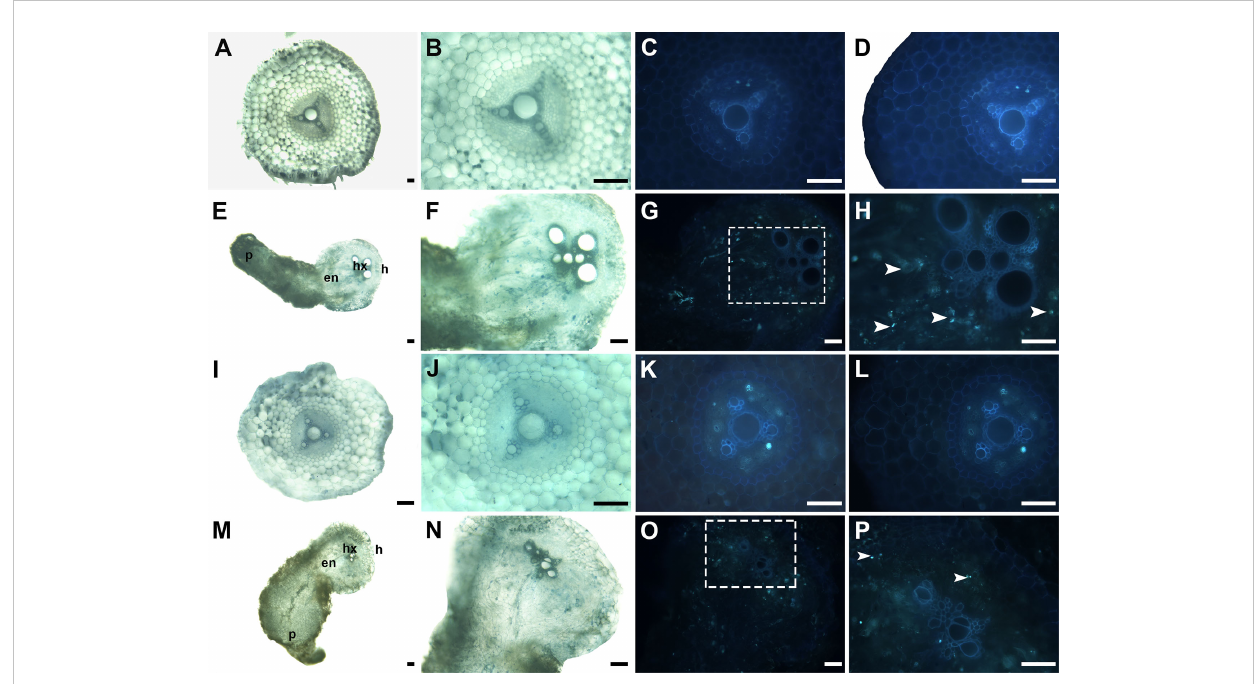
FIGURE 9 Cross-sections of incompatible and compatible interactions of P. aegyptiaca on KR1326 and K1076 stained with aniline blue at 16 DAI. Callose deposition shows as a blue-white fl uorescence (arrows). (A, B, E, F) Light micrographs of fresh hand-cut sections of noninfected (A, B) and infected (E, F) with broomrape roots of KR1326. (C, D, G, H) The same as (A, B, E, F) observed under fl uorescence (340 – 380 nm). (H) Magni fi cation of the square box in (G) . (I, J, M, N) Light micrograph of a fresh hand-cut section of a noninfected (I, J) and infected (M, N) with broomrape roots of K1076. (K, L, O, P) The same as (I, J, M, N) observed under fl uorescence (340 – 380 nm). (P) Magni fi cation of the square box in O. Bars = 100 m m. h, host; p, parasite ( P. aegyptiaca ); hx, host xylem; en,